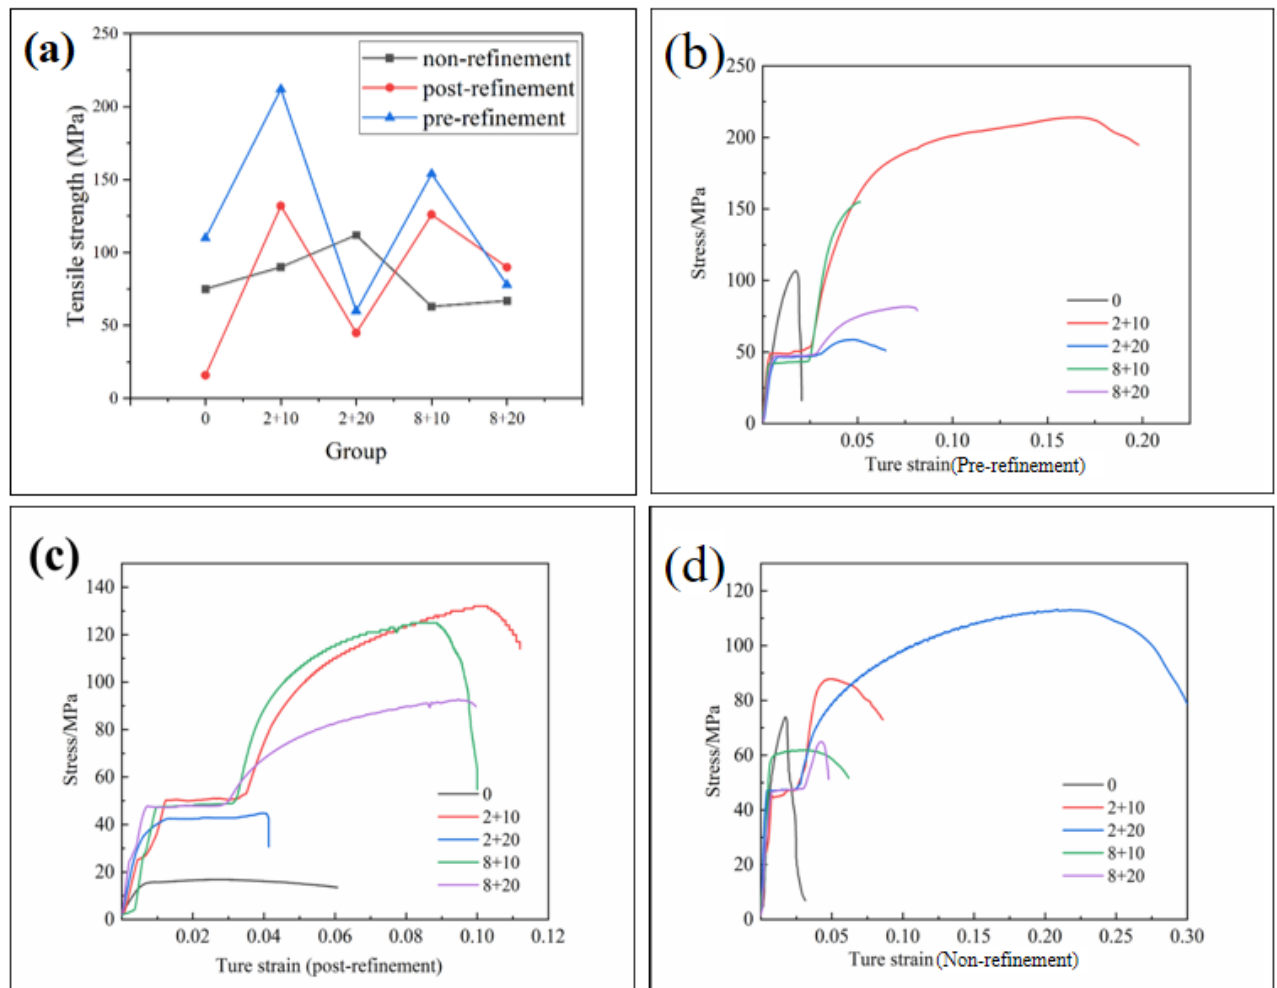
Figure 10. ( a ) Tensile strength of three casting alloys after “pre-refinement”, “post-refinement”, and “non-refinement” treatment; ( b ) tensile curves of “pre-refinement” casting alloys after different heat treatments; ( c ) tensile curves of “post-refinement” casting alloys after different heat treatments; ( d ) tensile curves of “non-refinement” casting alloys after different heat treatments.